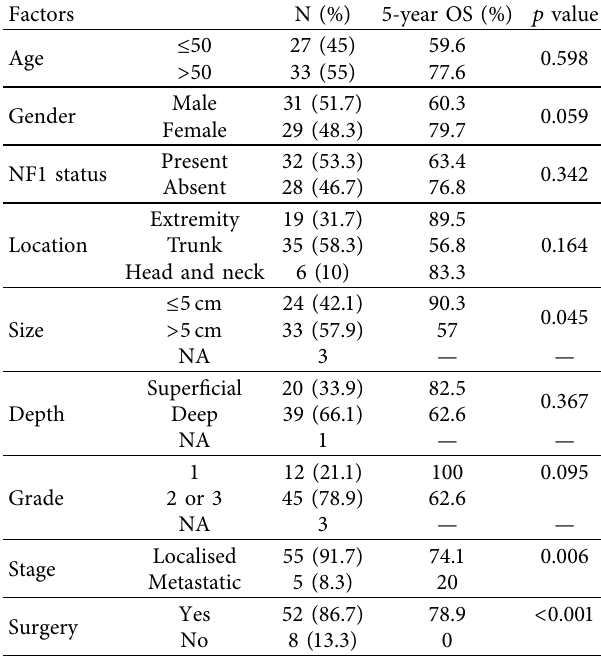
Table 1: Patient-, tumour-, and treatment-related characteristics and univariate analysis of prognostic factors for OS in 60 patients with